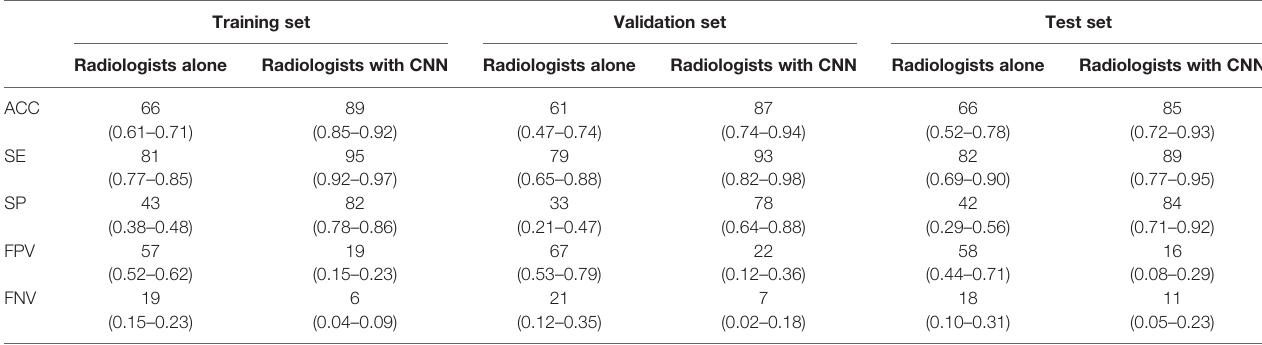
TABLE 3 | Comparison of the diagnostic performance of radiologists without and with the CNN